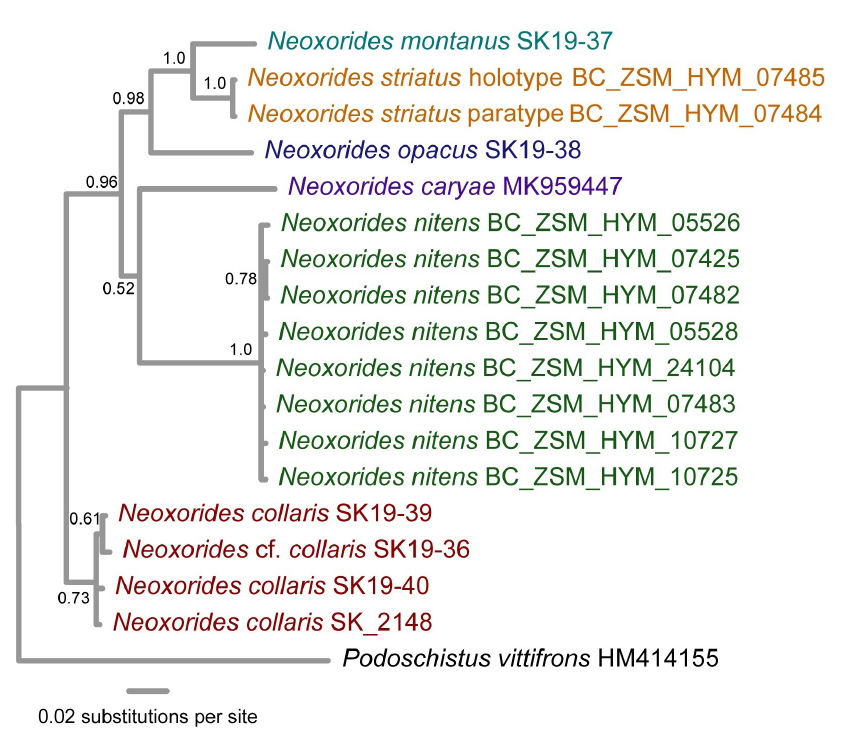
Fig. 3. Bayesian majority-rule consensus tree based on CO1 sequences, showing posterior probabilities of the recovered nodes within Neoxorides Clément,